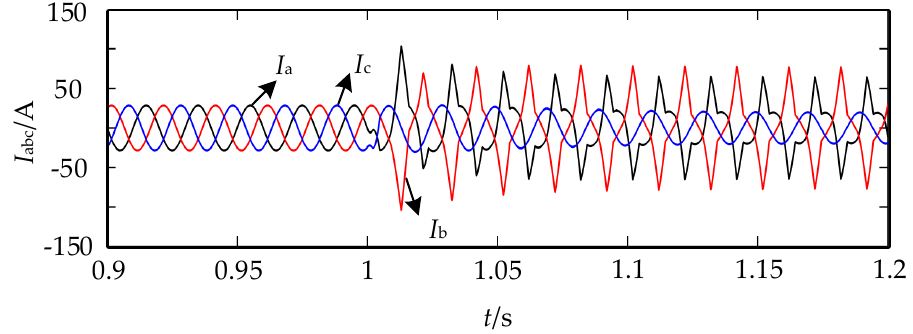
Figure 11. DC voltage with a PI current inner loop.